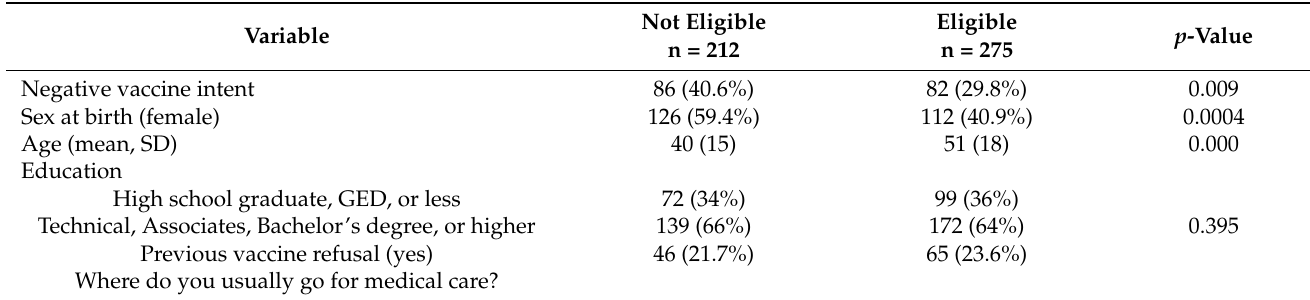
Table 1. Baseline Demographics of participants based upon vaccine eligibility at time of survey (n =